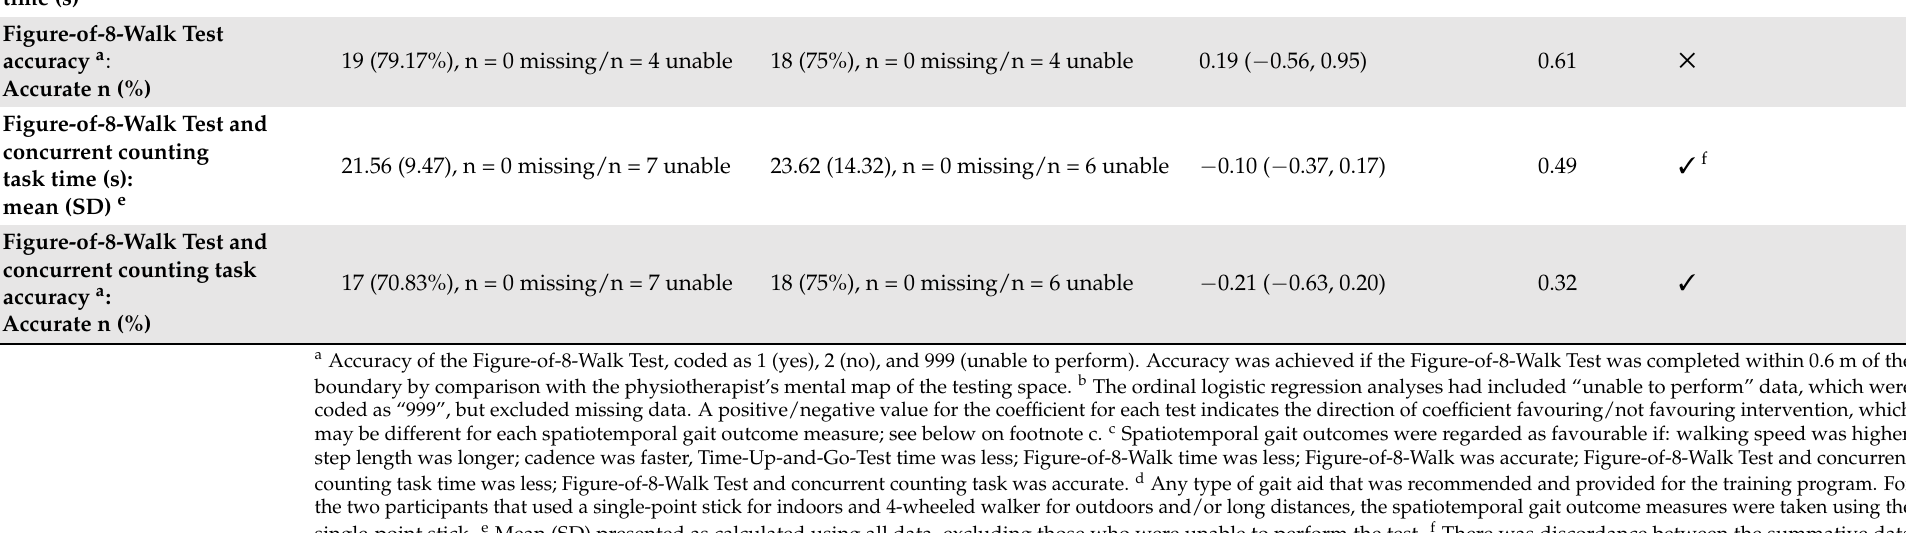
Figure-of-8-Walk Test